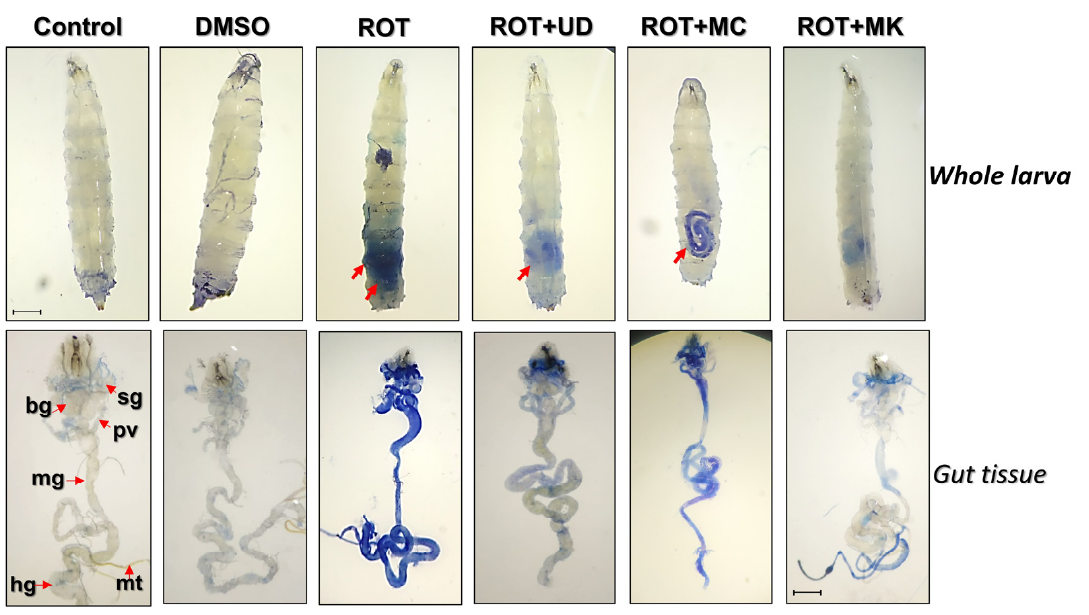
Figure 6. Dye exclusion test through trypan blue staining in third instar larvae exposed to rotenone and cotreated with UD, MC, and MK, as shown in the upper panels. The lower panels show dissected third instar larvae stained with trypan blue. Seventy-two hour ( ± 2 h) old larvae (early third instar) of D. melanogaster (Oregon R + ) were exposed to ROT 500 µ M alone or in combination with UD, MC, and MK for 48 h. Arrows of the upper panel show cytotoxicities in the whole larvae through trypan blue staining. Note: bg= brain ganglia, sg= salivary glands, pv= proventriculus, mg= midgut, mt= malpighian tubules, and hg = hind gut. The bar represents 100 µ m. ROT= rotenone; UD = Urtica dioica , MC = Matricaria chamomilla and MK= Murraya koenigii .